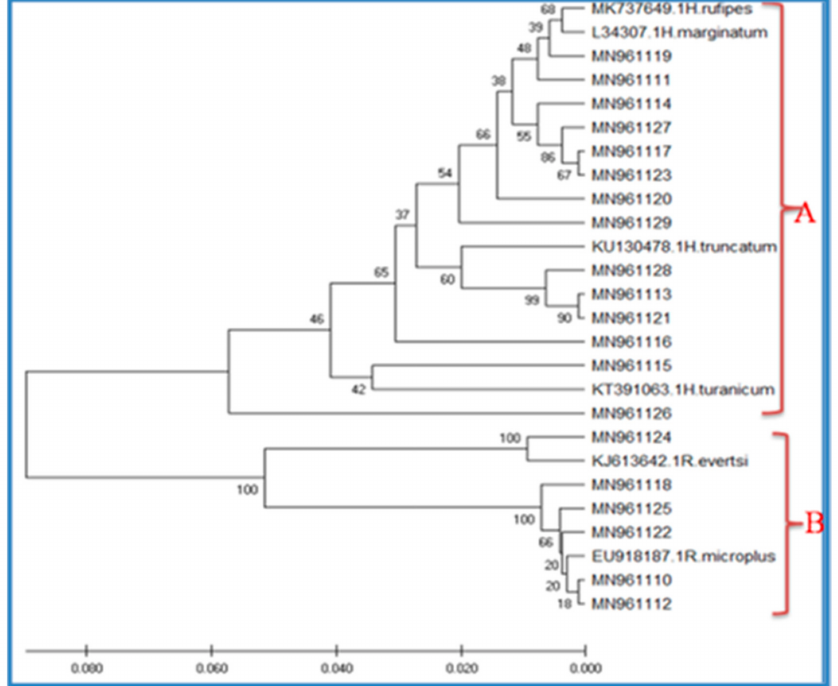
Figure 2. Overall phylogenetic tree (inferred using the Unweighted Pair Group Method with Arith- metic mean (UPGMA)) for tick species based on the 16S rRNA gene, including sequences obtained in the present study and representative sequences of the known species from GenBank (indicated with a species name). A and B in the phylogenetic tree are the